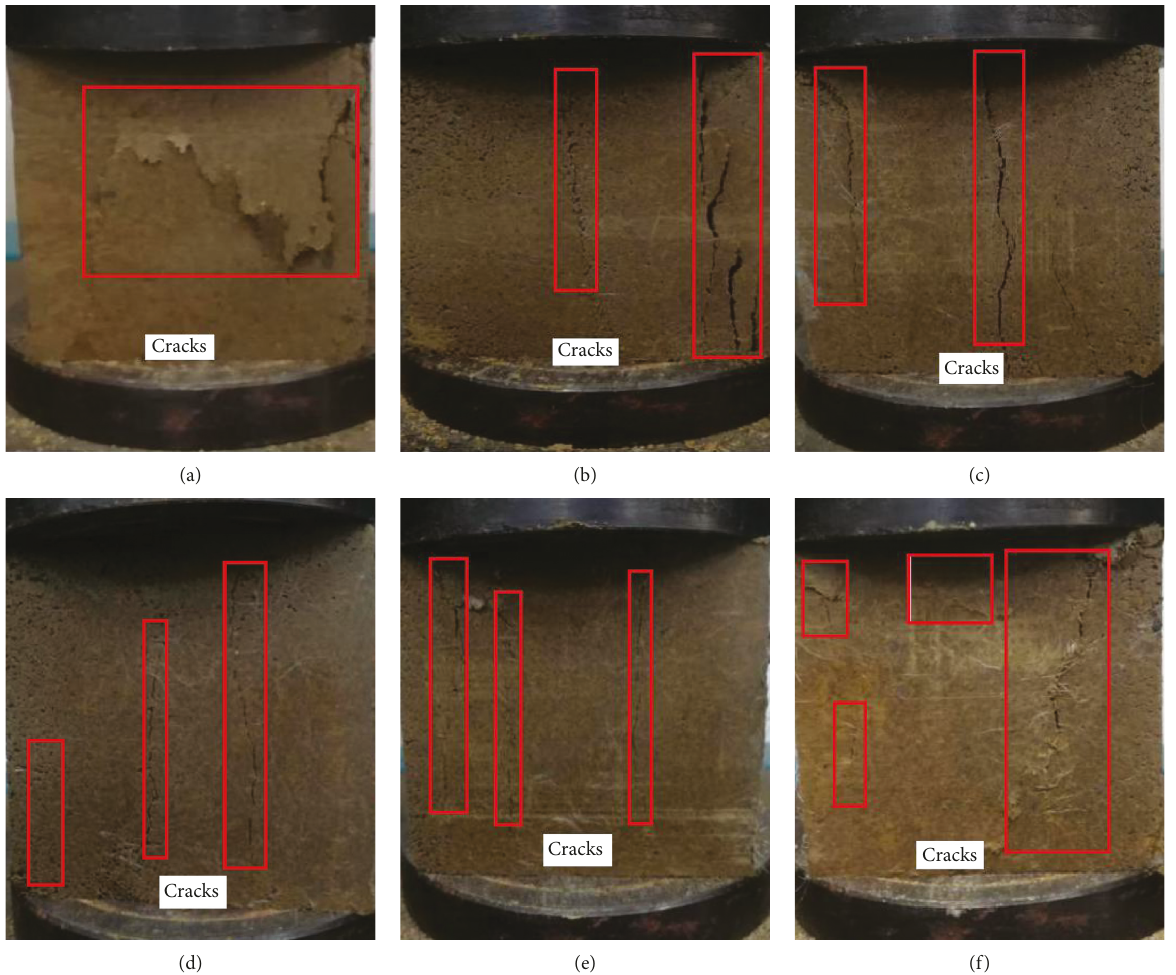
Figure 12: The final failure mode of soil-cement with different polypropylene fiber contents. (a) FA-0%, PP-0%. (b) FA-0%, PP-0.1%. (c) FA-0%, PP-0.2%. (d) FA-0%, PP-0.3%. (e) FA-0%, PP-0.4%. (f) FA-0%,